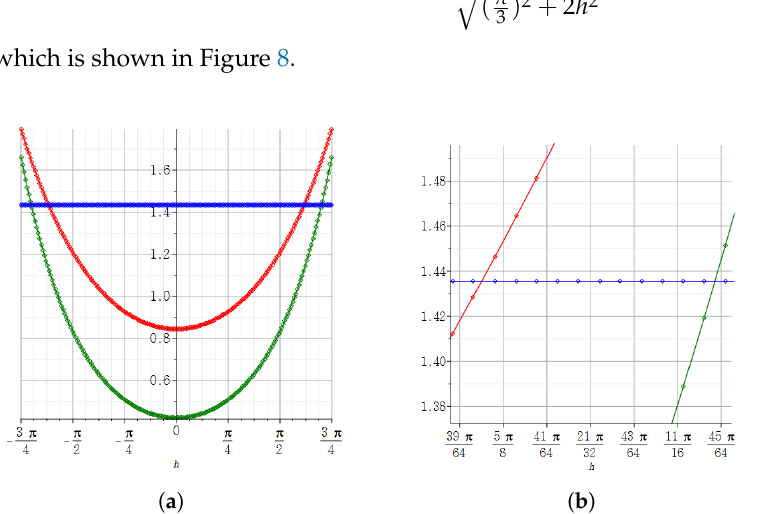
Figure 7. ( a ) The result obtained by using the Maple plot to see what the step derivative has according to the size of h . ( b ) In the graph of ( a ), the result of zooming in about h near the midpoints of 5 π 11 π . In ( a , b ), the green graph represents the ( j , k ) -step derivative, the red graph represents the j -step 16 derivative of cos z at z 0 according to the size of h , and the blue constant graph represents the absolute value of the derivative of cos z at z 0 by the definition of the derivative for a complex system.